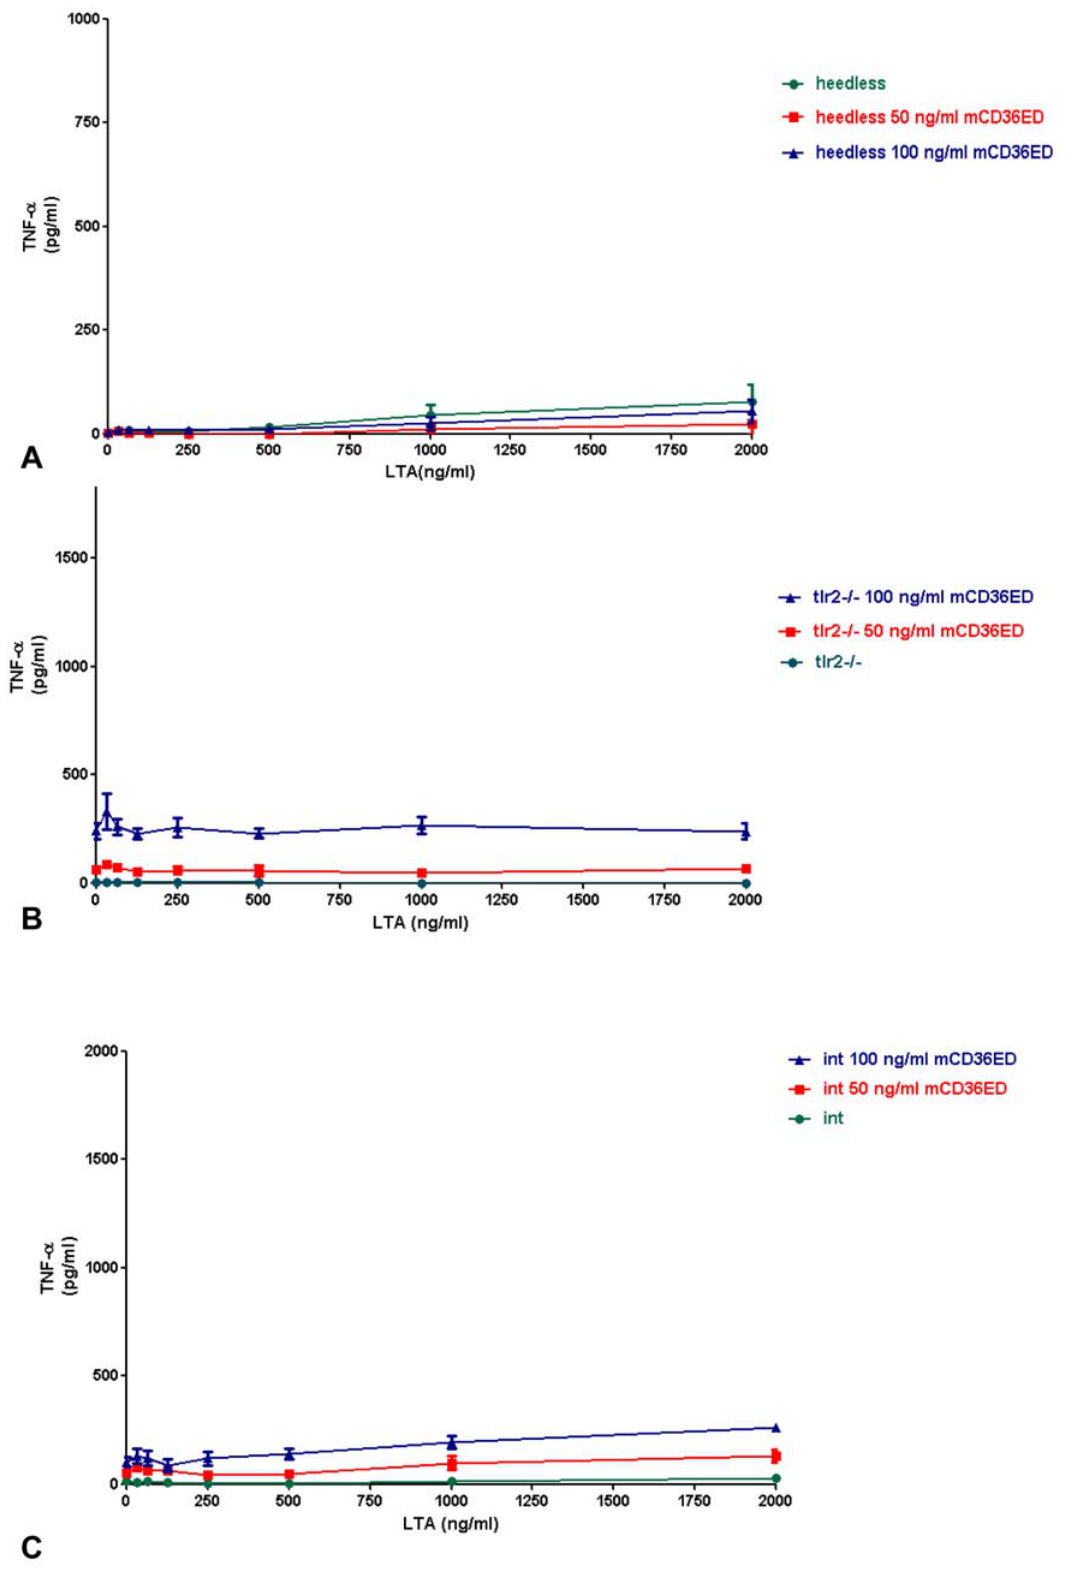
Figure 5. mCD36ED does not rescue deficient TNF- a secretion by LTA in the case of macrophages extracted from (A) heedless , (B) tlr2 2 / 2 and (C) insouciant (int) mice. Macrophages from tlr2 2 / 2 , heedless and insouciant macrophages were exposed to different concentration of LTA plus a constant amount of mCD36ED for 4 hours. The amount of TNF- a secreted to the supernatant was determined by an L929 cytotoxic assay. Values are expressed as mean values + / 2 SEM (n=3 mice).